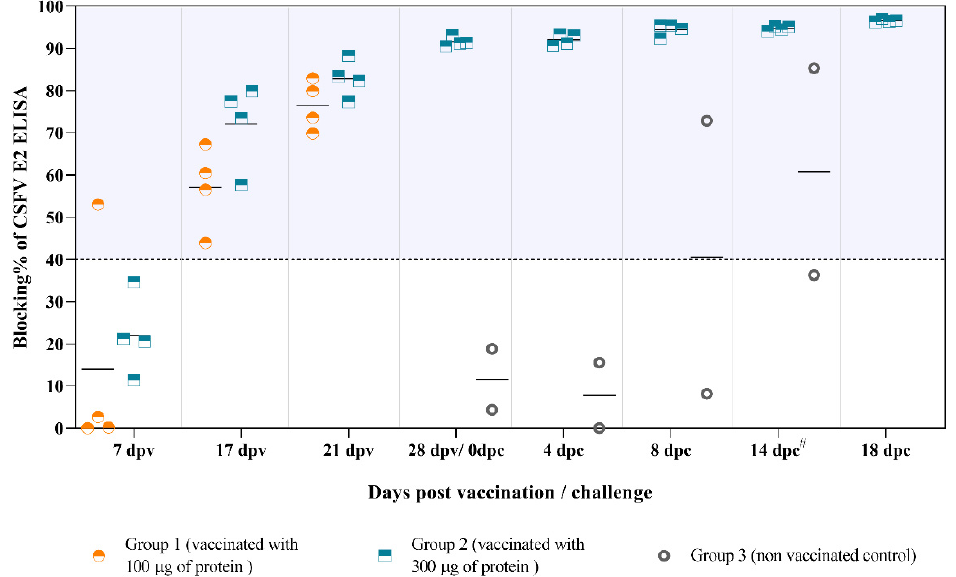
Figure 1. The antibody responses against the E2 glycoprotein after vaccination and challenge. The E2-specific antibody response was analyzed by ELISA and represented as blocking percentage (blocking %). Blocking % values equal to or greater than 40% were considered as positive. # : Sows 9 and 10 were euthanized at 10 dpc due to severe clinical signs and the data are represented at this time-point.